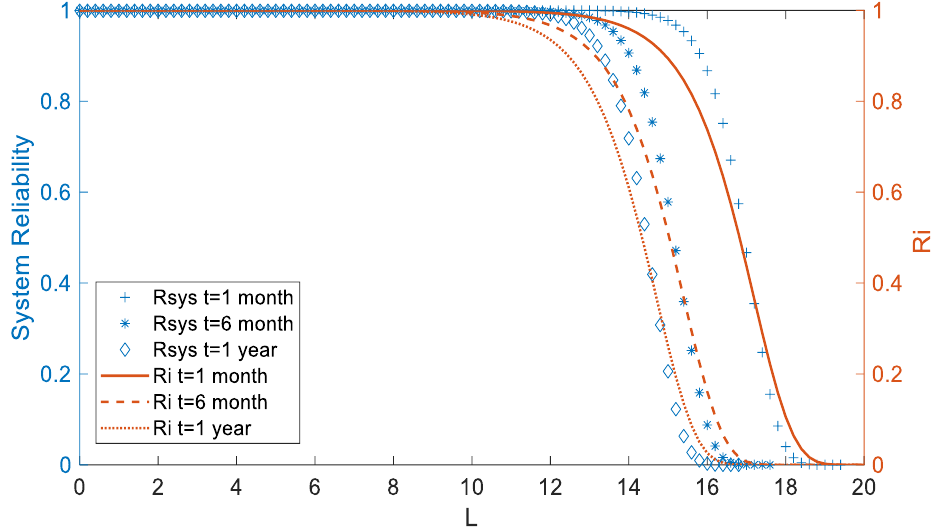
Figure 6. R i ( L ) and R sys (L ) at different t under α i = 1, 𝑖 ∈ {𝑆𝑤𝐴1, 𝑆𝑤𝐴2, 𝑆𝑤𝐵1, 𝑆𝑤𝐵2}